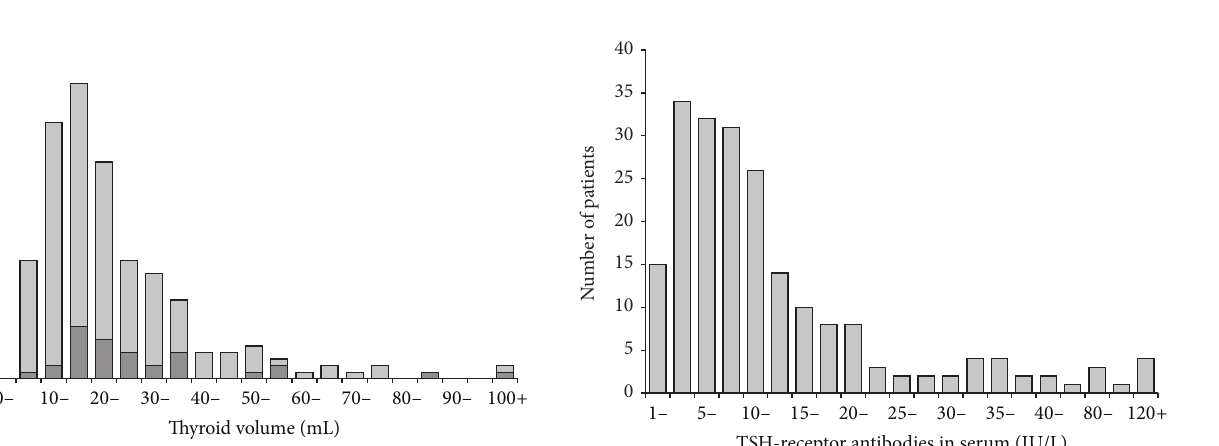
Figure 3: Distribution of serum TRAb values in patients with newly diagnosed hyperthyroidism caused by Graves’ disease and enrolled in the RISG study. According to inclusion criteria, none had TRAb < 1.0 IU/L. Up to 40IU/L, intervals are 2.5 IU/L wide. At 40 IU/L and above, intervals are 20 IU/L